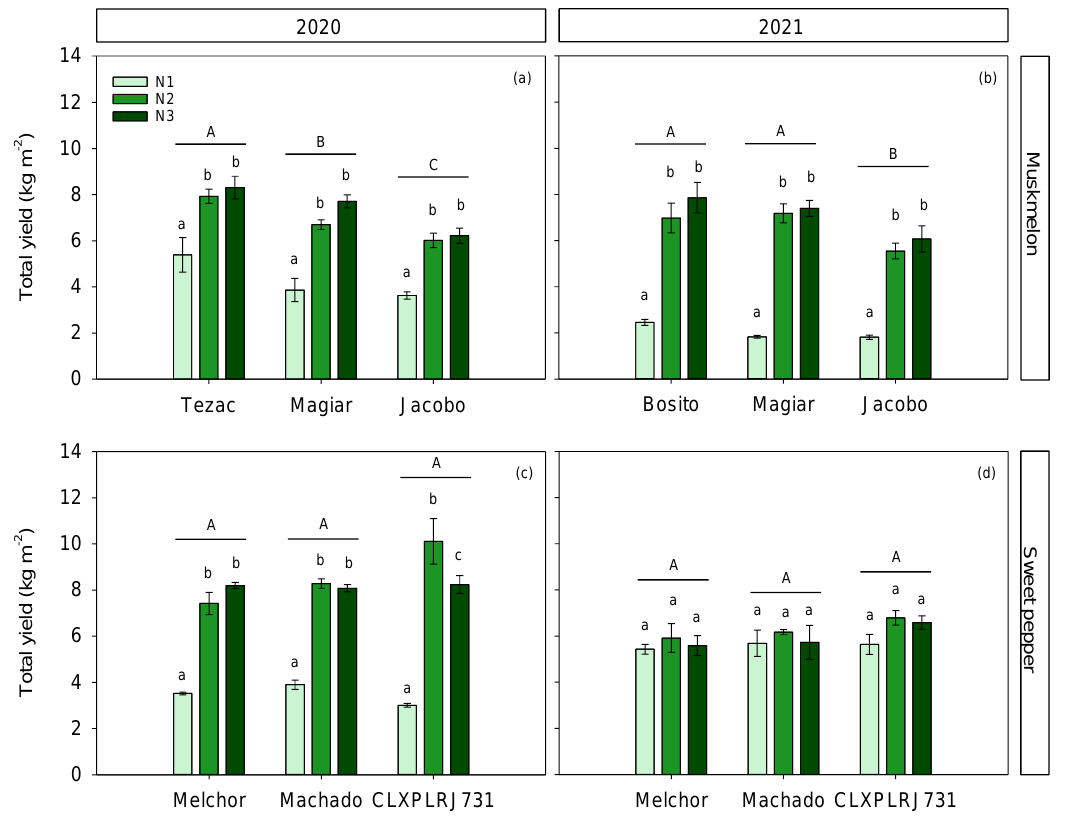
Figure 1. Total yield for three cultivars and three N treatments, for muskmelon ( a , b ) and sweet pepper ( c , d ) crops, conducted in 2020 and 2021 years. Different lowercase letters show significant differences between N treatments within each cultivar; different uppercase letters show significant differences between cultivars. Values are means ± SE.